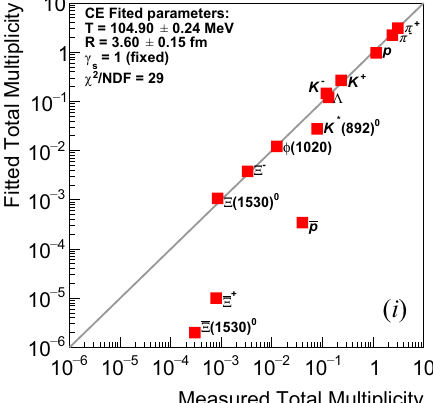
pared with mean multiplicities obtained from the HRG model based on the Canonical Ensemble with fixed γ s = 1 (i) and fitted γ s (ii). Uncer- tainties of the measurements are smaller than the size of the